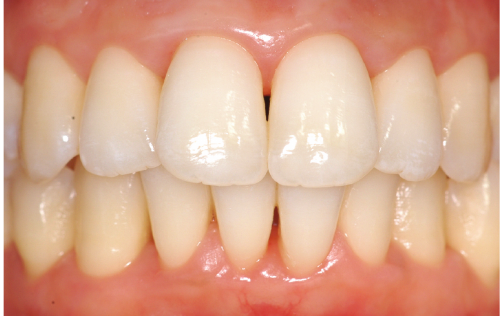
Figure 7: Frontal view of clinical situation after 12-month follow- up